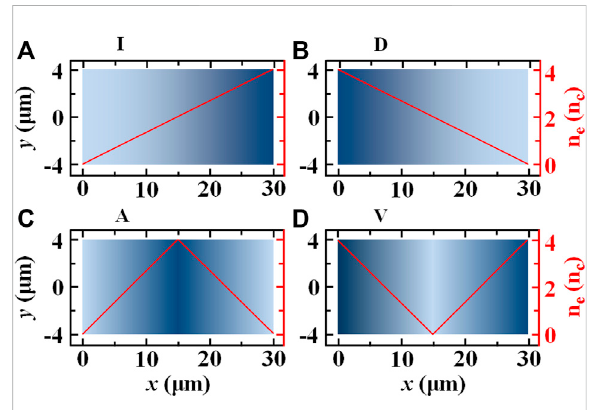
FIGURE 1 Schematics of four types of plasmas: type I is linearly increasingdensityplasmas (A) ;typeDislinearlydecreasingdensity plasmas (B) ; type A is fi rst increasing and then decreasing density plasmas (C) ;and typeV is fi rst decreasing and then increasing density plasmas (D)